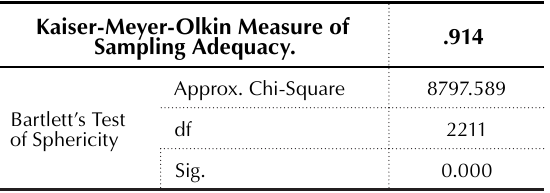
Table 3. KMO and Bartlett’s Test